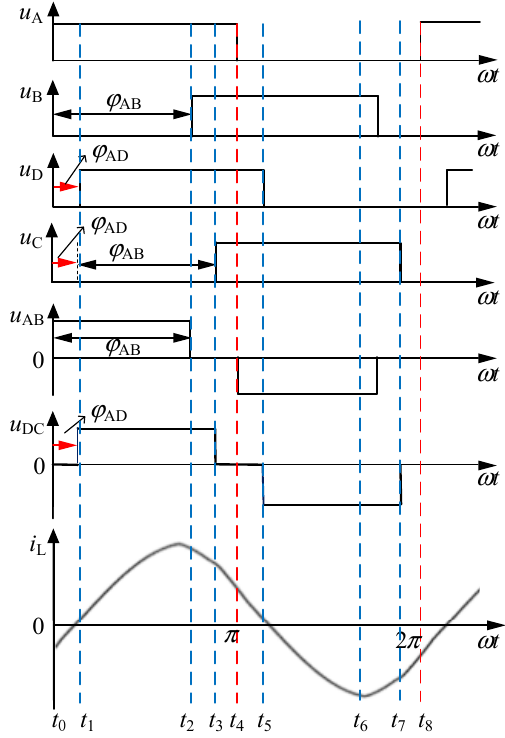
Figure 4. Work waveform under DPS